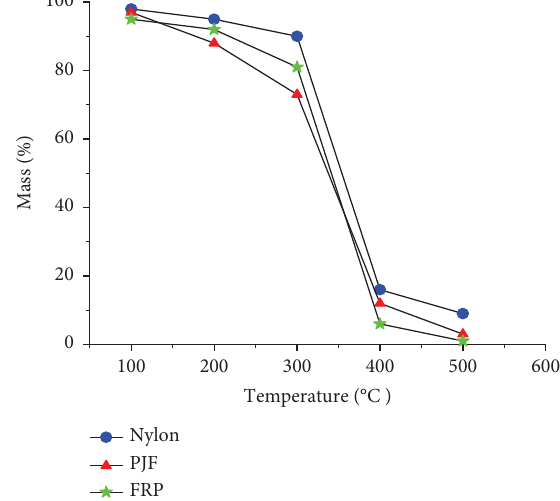
Figure 8: TGA curves of the cabinet dryer